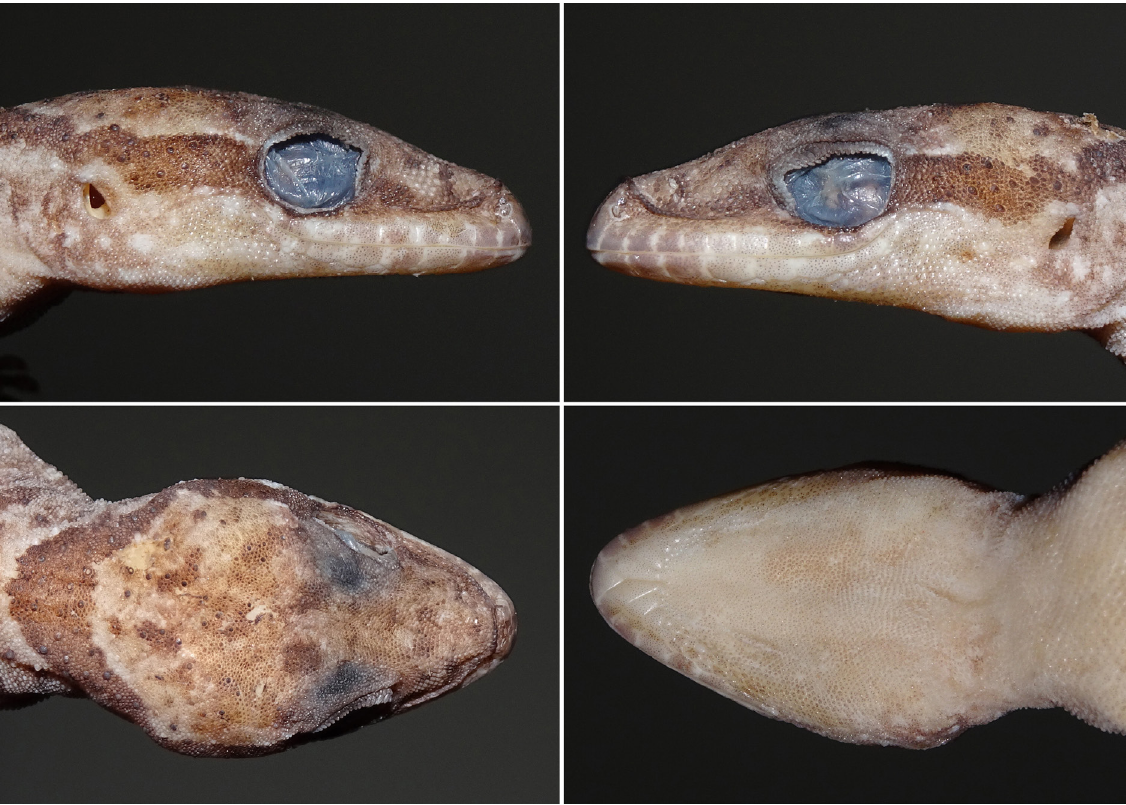
Fig. 7. Head views in preservative of Cyrtodactylus chungi sp. nov. from Ta Kou Nature Reserve, Binh Thuan Province, Vietnam. On the left: holotype, ♂ (IEBR 4581); on the right: paratype, ♀ (IEBR 4582). Top: lateral view. Bottom left: dorsal view. Bottom right: ventral view. Photos T.